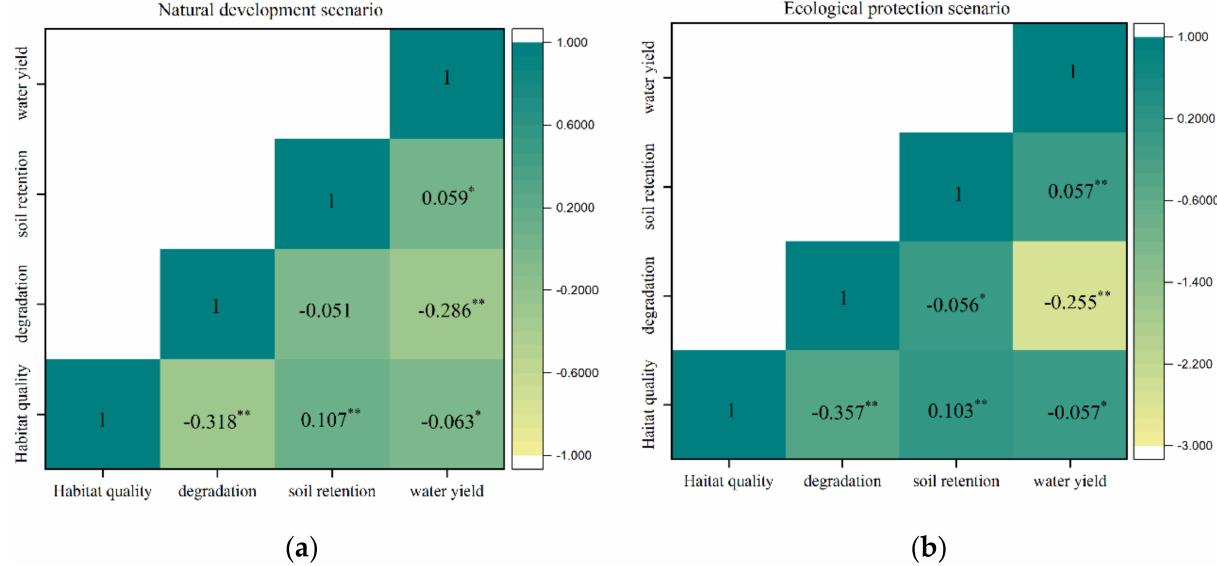
Figure 7. Trade-offs and synergies between ecosystem services and ecological degradation under ( a ) the natural development scenario and ( b ) the ecological protection scenario. * represents p < 0.05, and ** represents p <